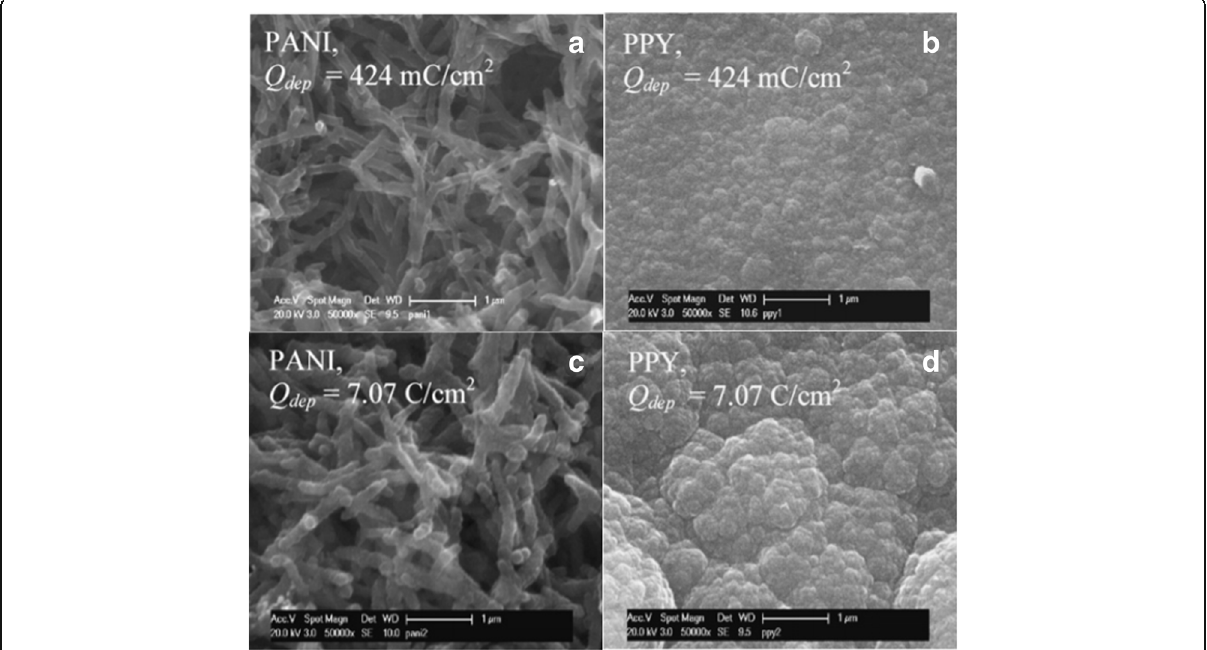
Fig. 7 SEM images of the surfaces pure PANI and PPy films at low (424 mC/cm 2 ) and high (7.07 C/cm 2 ) deposition charges (Q dep ) as indicated. Reprinted with permission from [46]. Copyright 2007